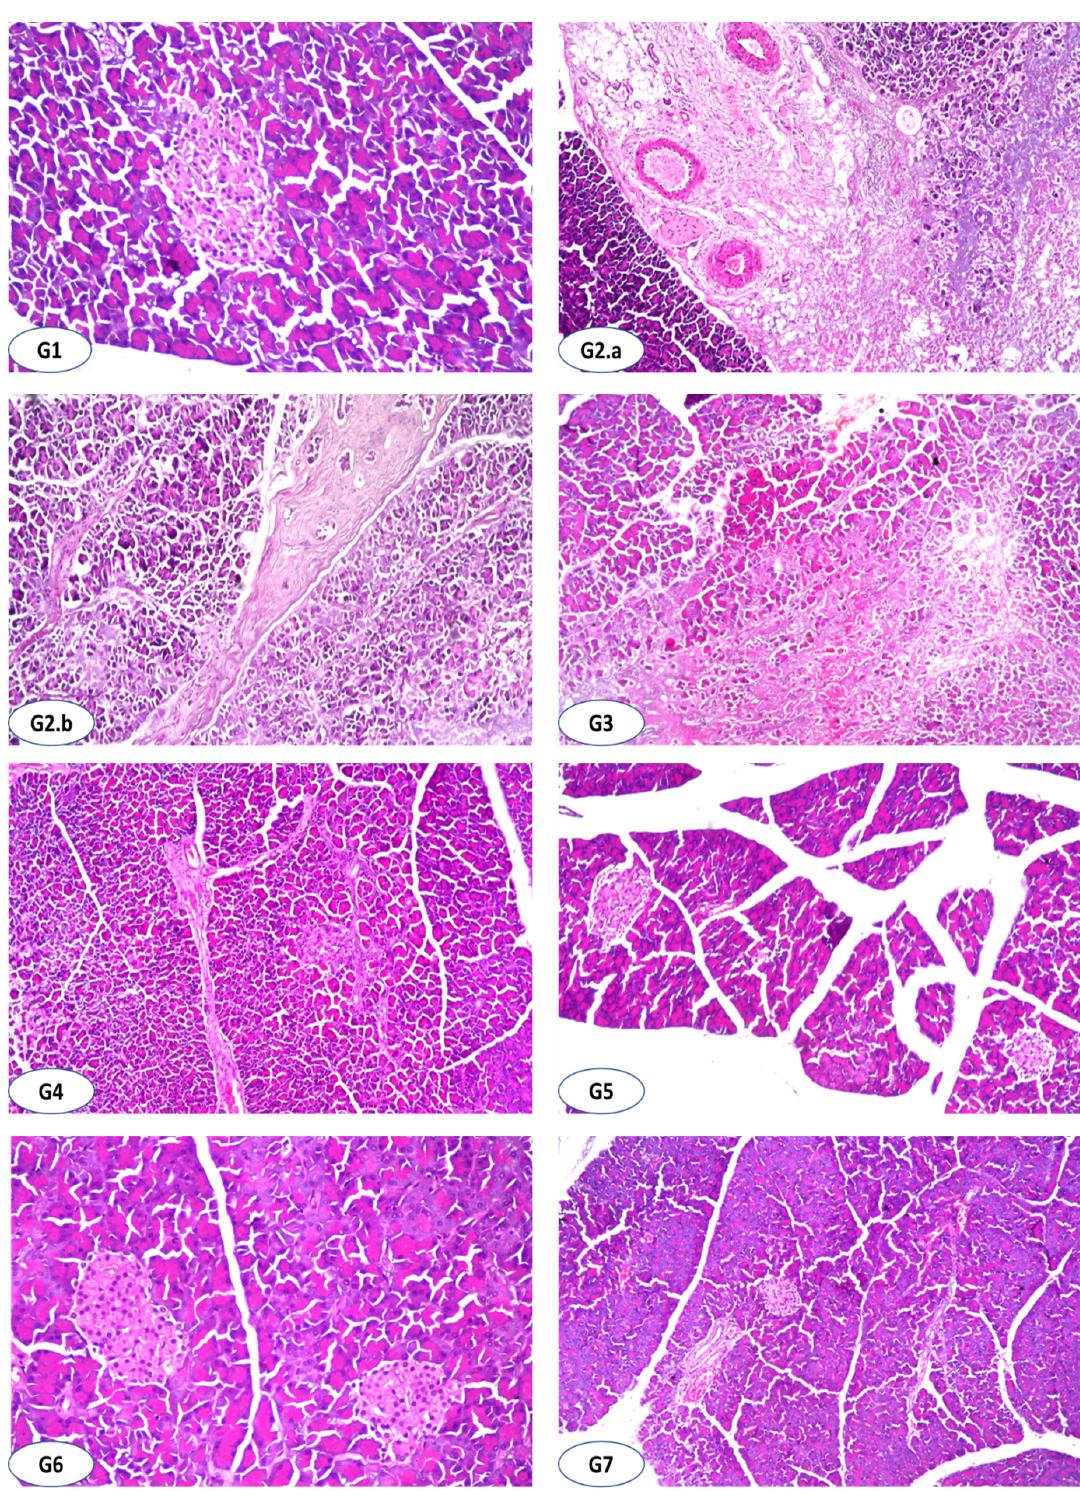
Figure 1. Histopathological findings of rats’ pancreas of the experimental groups (Hematoxylin-Eosin, HE; x 16 ). ( G1 ): Showing normal histological structure of the islets of Langerhans cells as endocrine portion with the acini and duct system of the exocrine ( x 16). ( G2 ) (a,b): Showing interlobular fibrosis with atrophy of islets of Langerhans and the acini. ( G3 ): Showing intact islet of Langerhans cells with fine fibrosis between the lobules. ( G4 ): Showing atro- phy in islets of Langerhans cells with necrobiosis in the acini. ( G5 – G7 ): Showing normal histological structure of both islet of Langerhans cells and